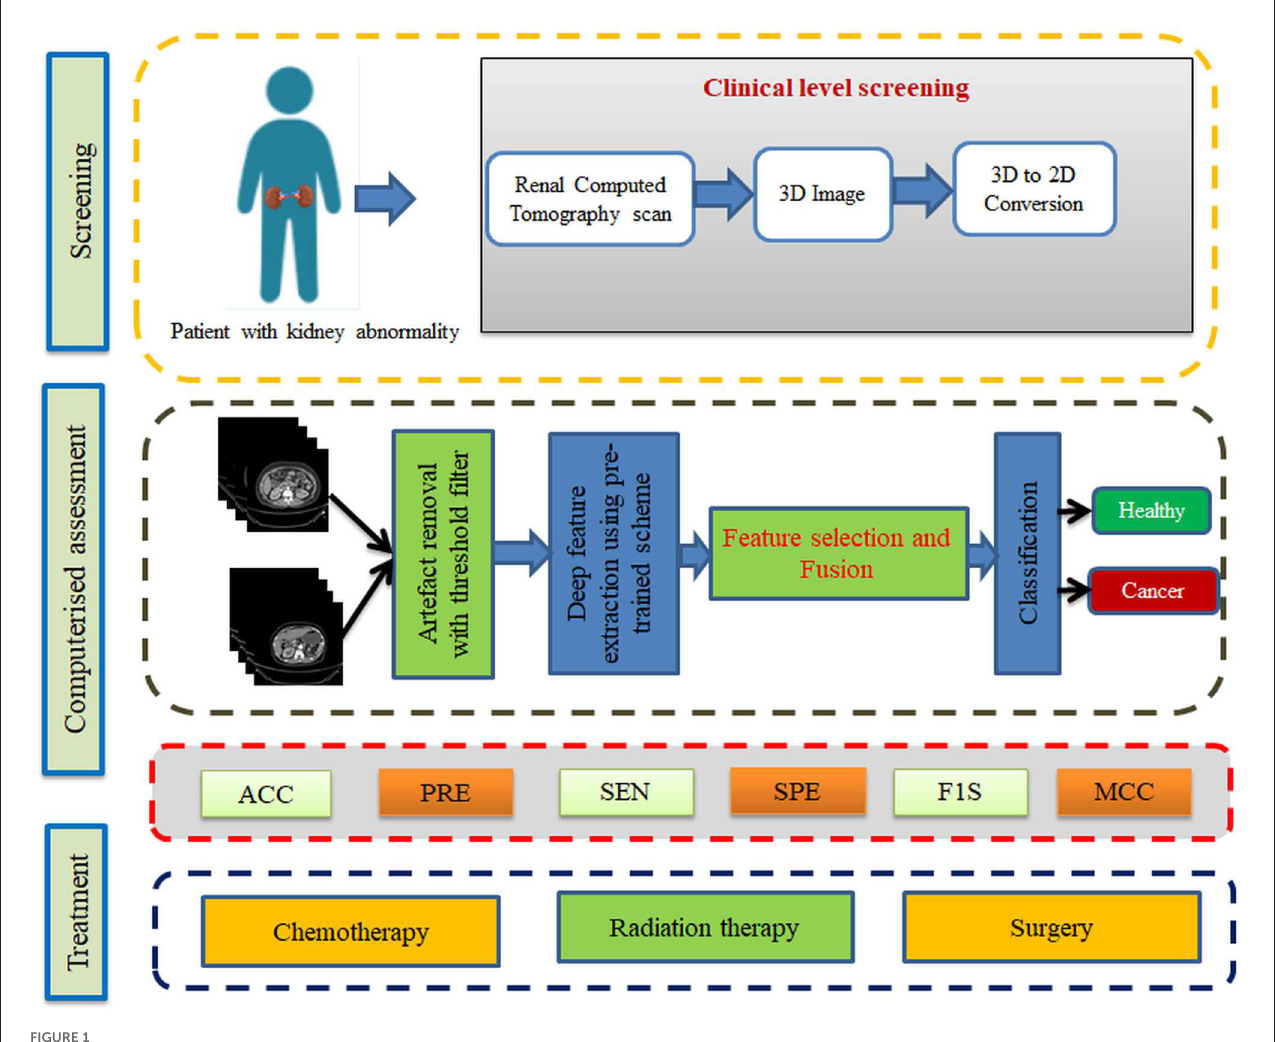
FIGURE1 Kidney cancer detection framework.